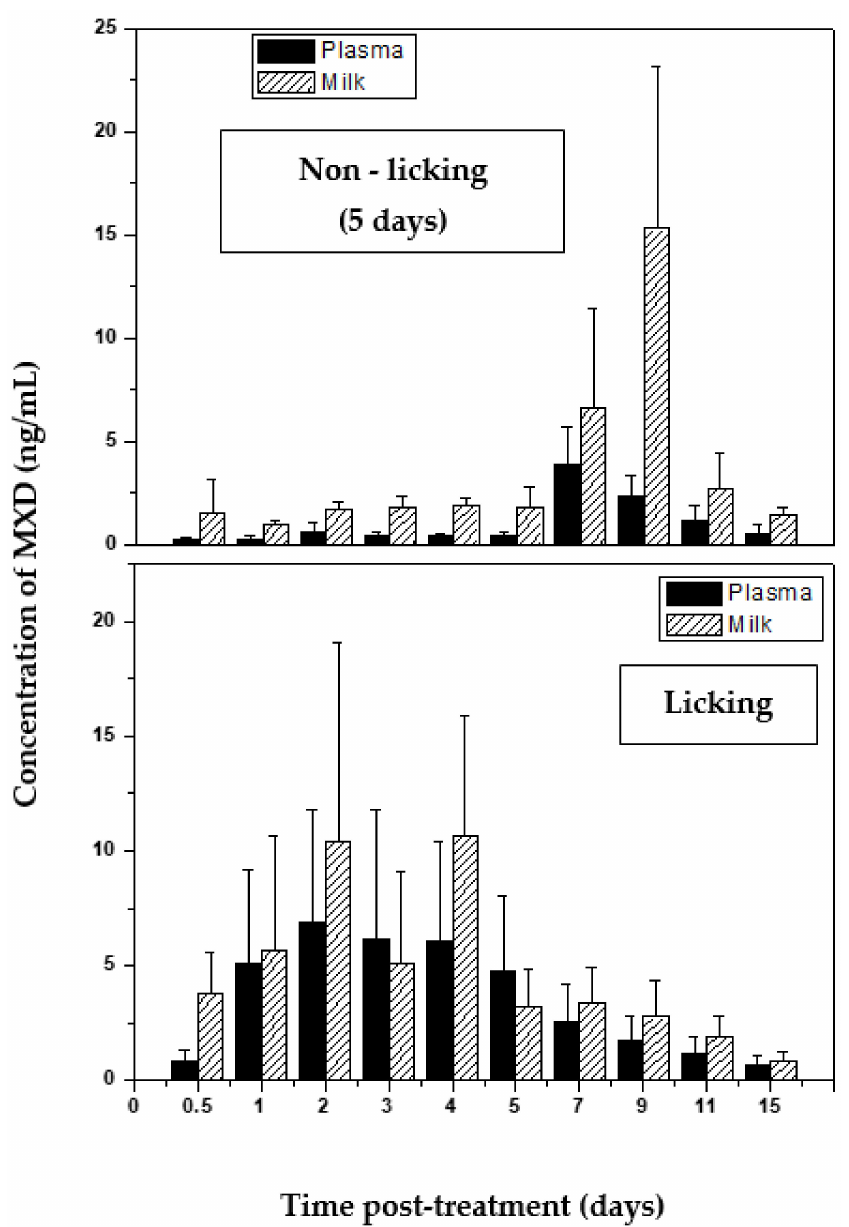
Figure 2. Comparative profiles of moxidectin (MXD) concentration (mean ± SD) ( n = 5) in plasma and milk after its pour-on administration (0.5 mg/kg) in licking-restricted (5 days) and free-licking dairy cows. Source: Adapted from Imperiale et al.